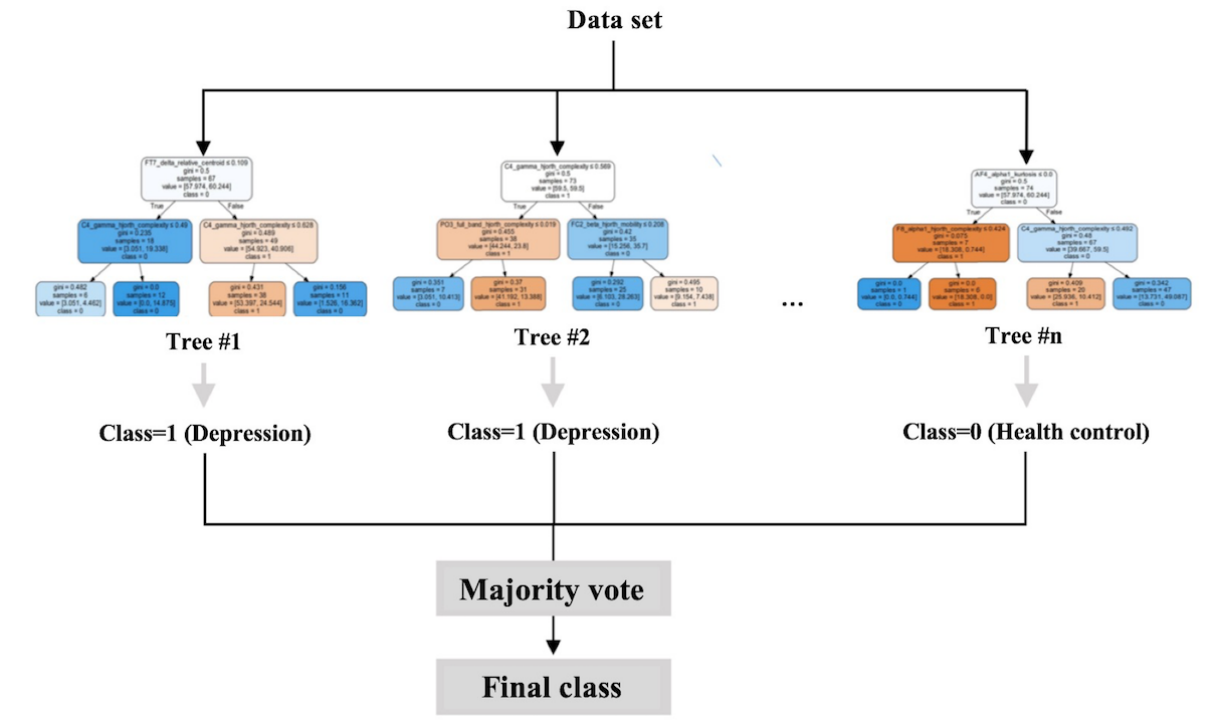
Figure 6. Mechanism of a random forest.